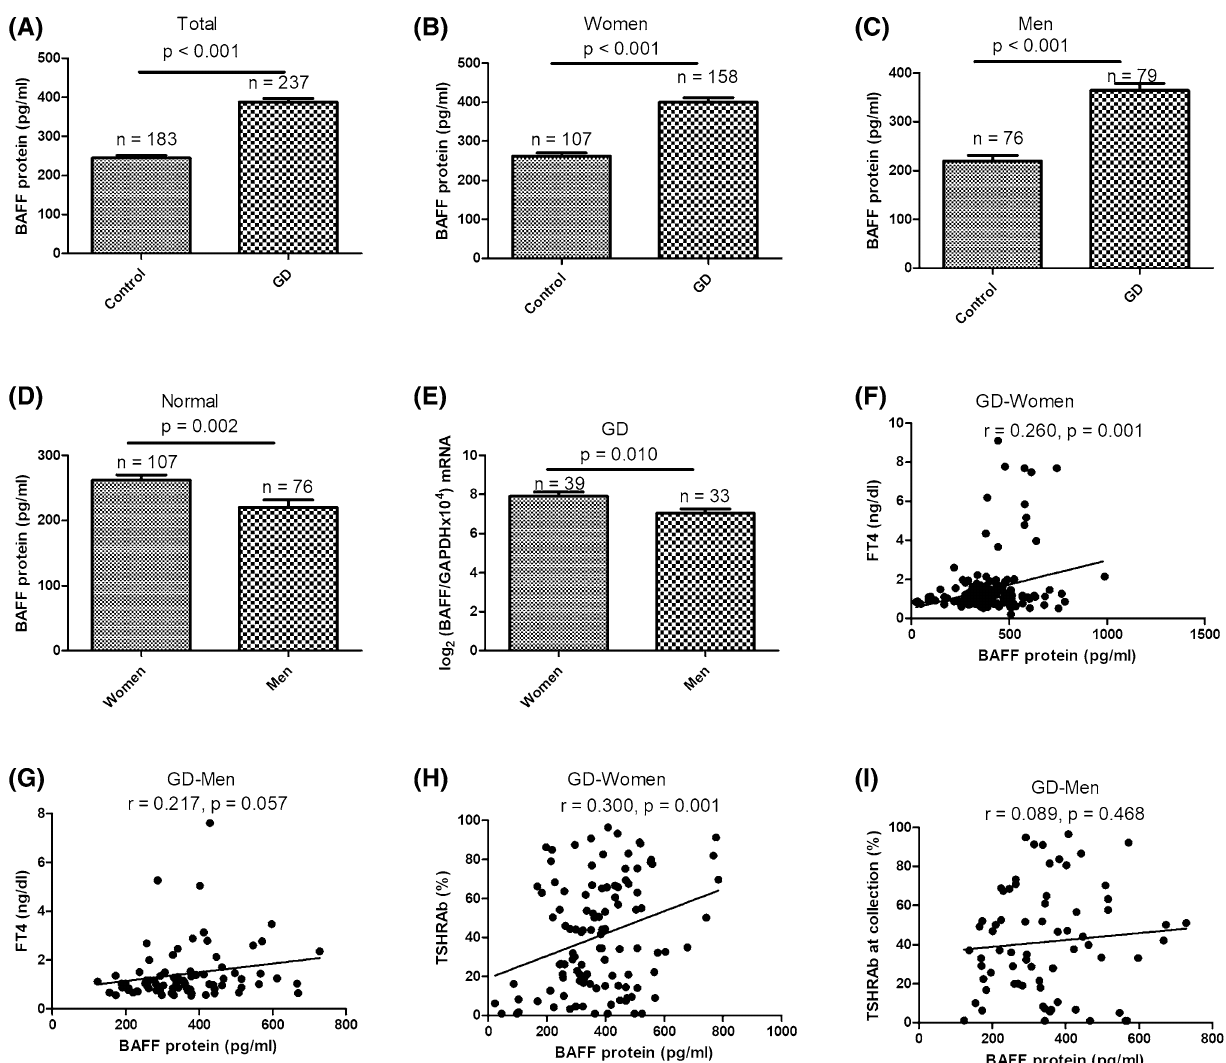
Figure 1. Comparisons of serum B-cell-activating factor (BAFF) protein levels between Graves’ disease (GD) and control subjects in ( A ) all, ( B ) female, and ( C ) male subjects, BAFF protein levels between women and men in normal subjects ( D ) and GD patients ( D , E ), and associations of BAFF protein levels with free thyroxine (FT4) in women ( F ) and men ( G ) with GD, and thyroid-stimulating hormone receptor antibody (TSHRAb) titers in women ( H ) and men ( I ) with GD. Data are expressed as the mean ± standard error. p < 0.05 indicates statistical